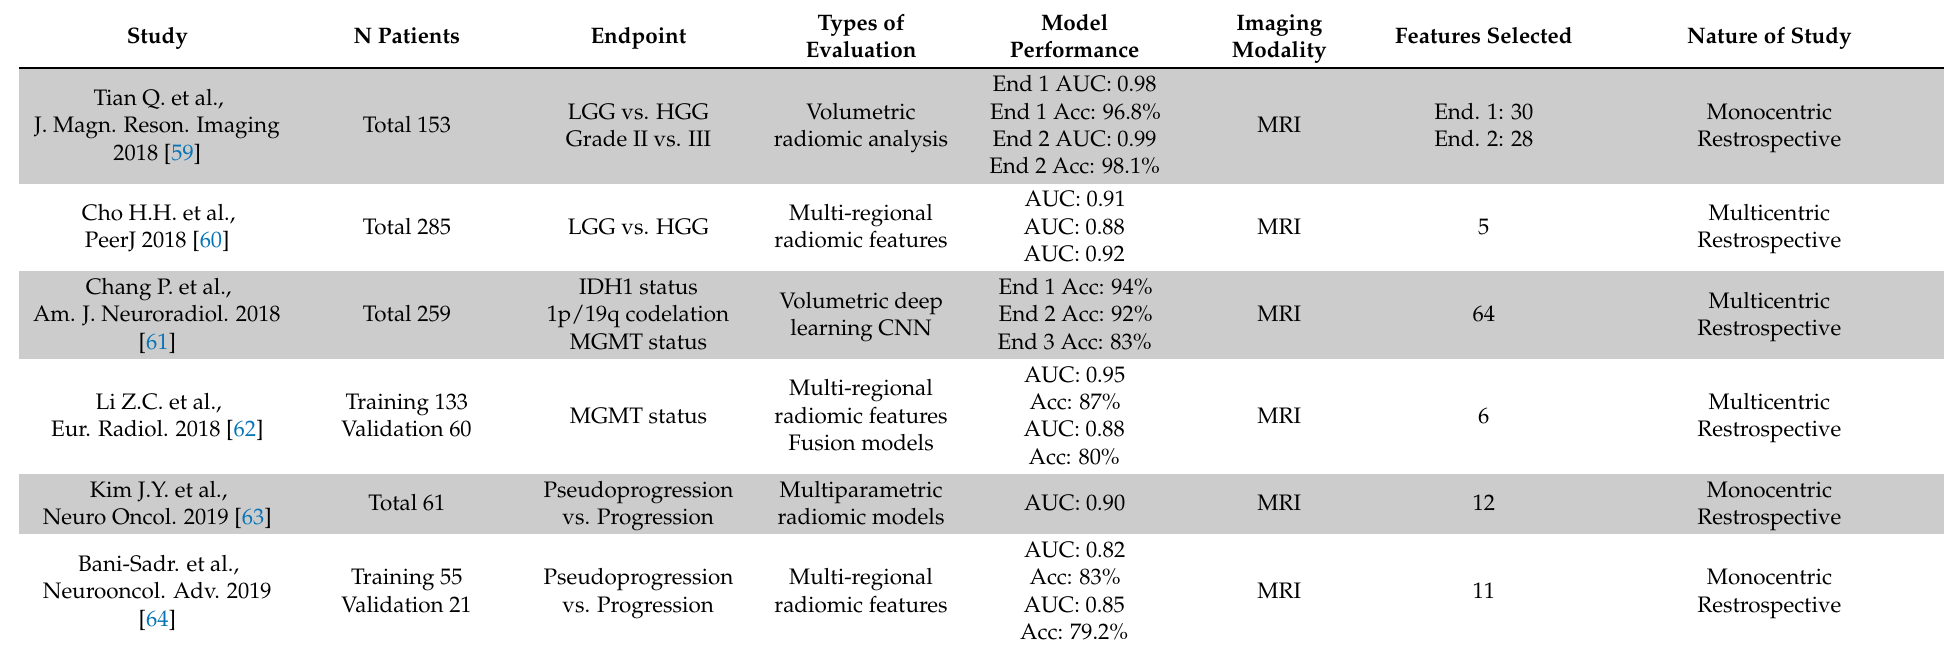
Table 3. Table summarizing the main studies regarding Radiomics applied to